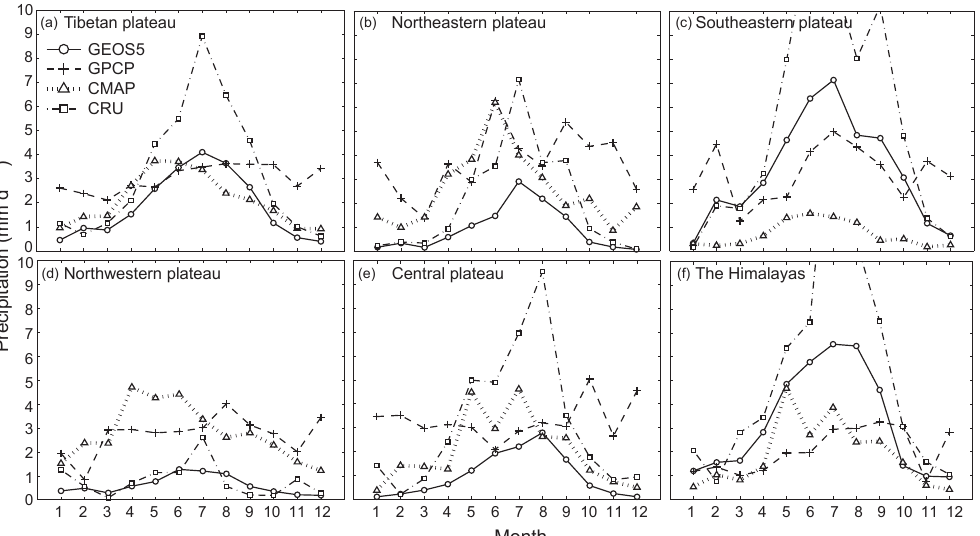
Figure 7. Monthly mean precipitation (mm d − 1 ) in 2006, averaged over different parts of the Tibetan Plateau (see Fig. 1). Data are from the Goddard Earth Observing System Model version 5 data assimilation system (GEOS-5 DAS), Global Precipitation Climatology Project (GPCP), NOAA Climate Prediction Center (CPC) Merged Analysis of Precipitation (CMAP), and Climate Research Unit (CRU) of Univer- sity of East